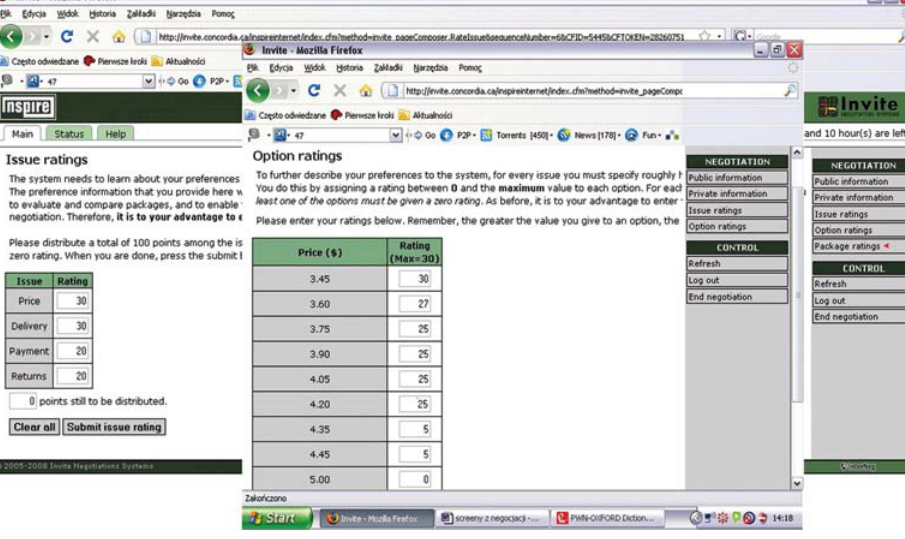
Fig. 2. Additive scoring system in ENS